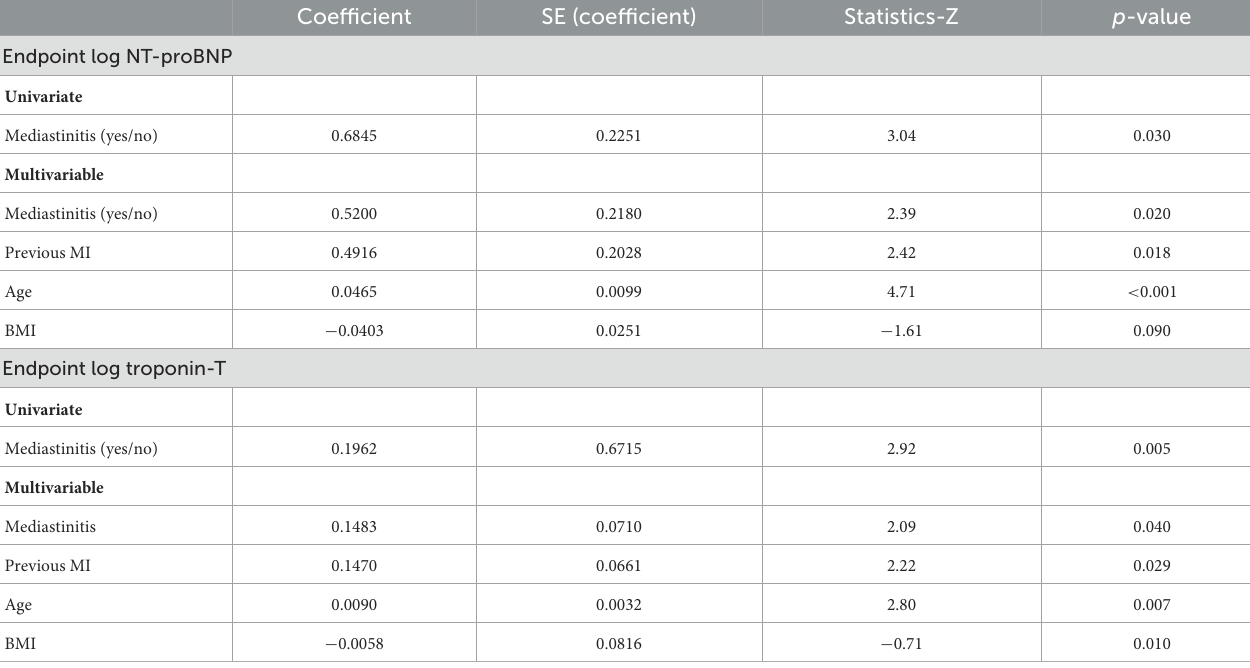
TABLE 2 Univariate and multivariable-adjusted effect of mediastinits on log NT-proBNP and log troponin-T. Coefficient SE (coefficient)